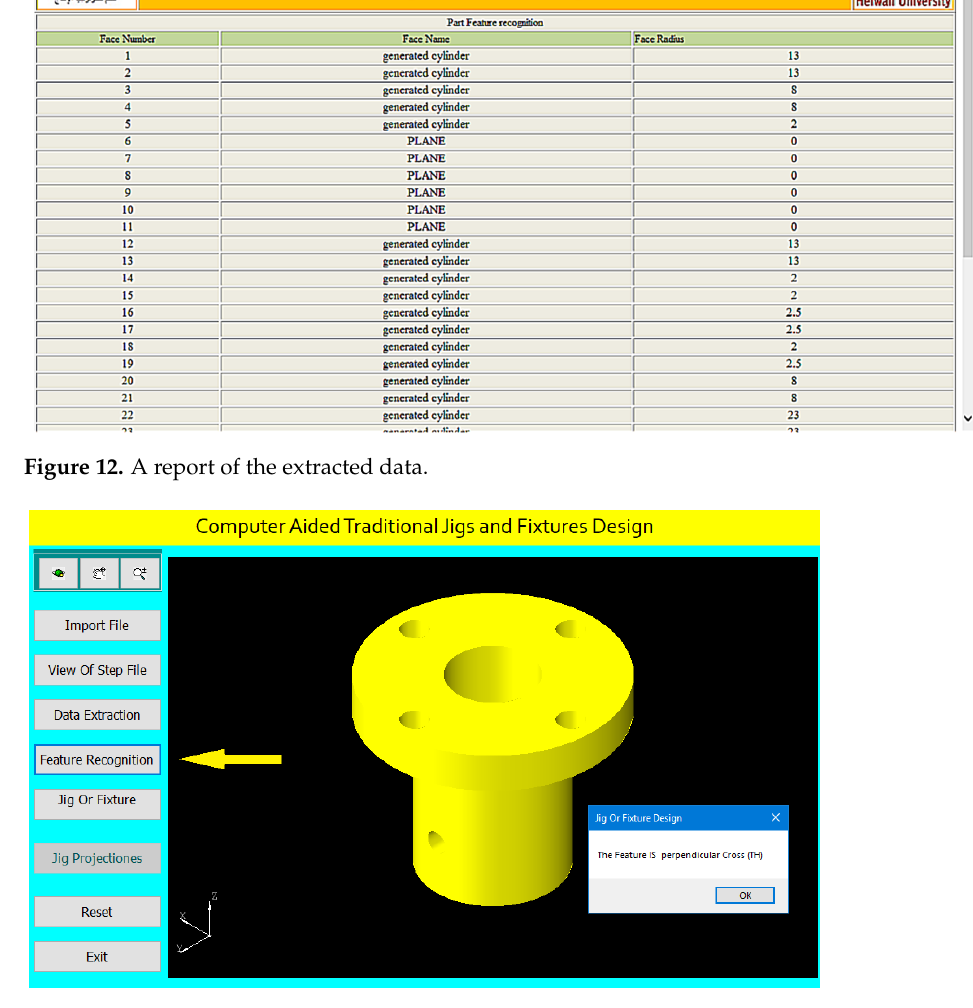
Figure 13. The fourth screen of the system interface.